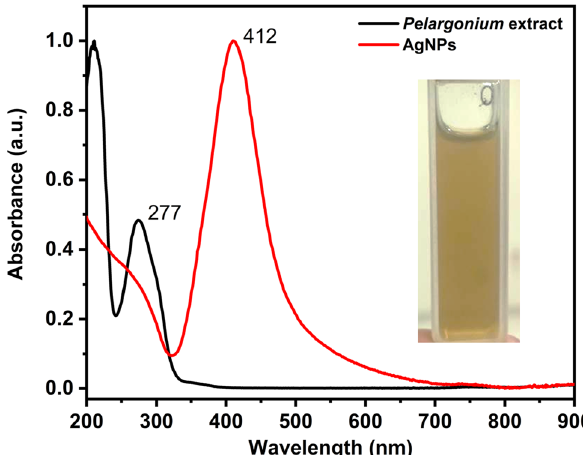
Figure 1: Represents the optical study of Pelargonium extract and synthesized AgNPs using UV - Vis spectroscopy ( inset: shows the color of AgNPs after being reduced by Pelargonium extract )